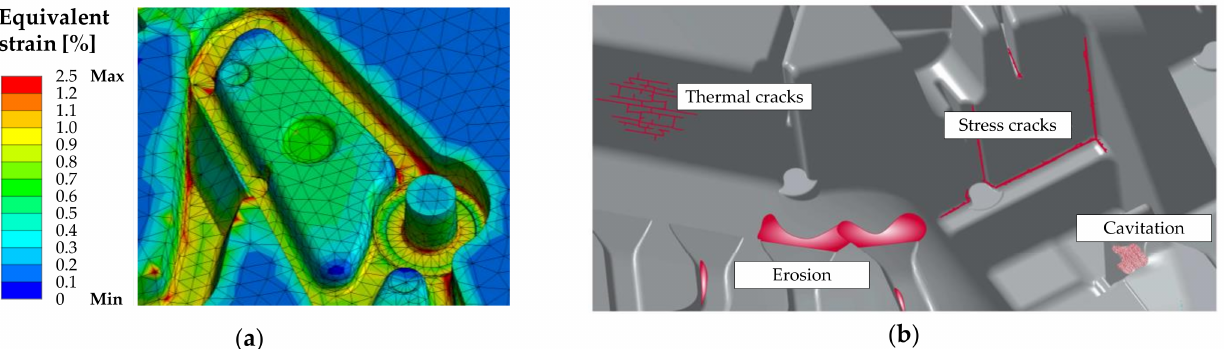
Figure 1. A simulated result of a lifetime calculation to determine critical die contours ( a ) and schematic representation of a die contour with the main described damages and their typical related occurring areas ( b ).